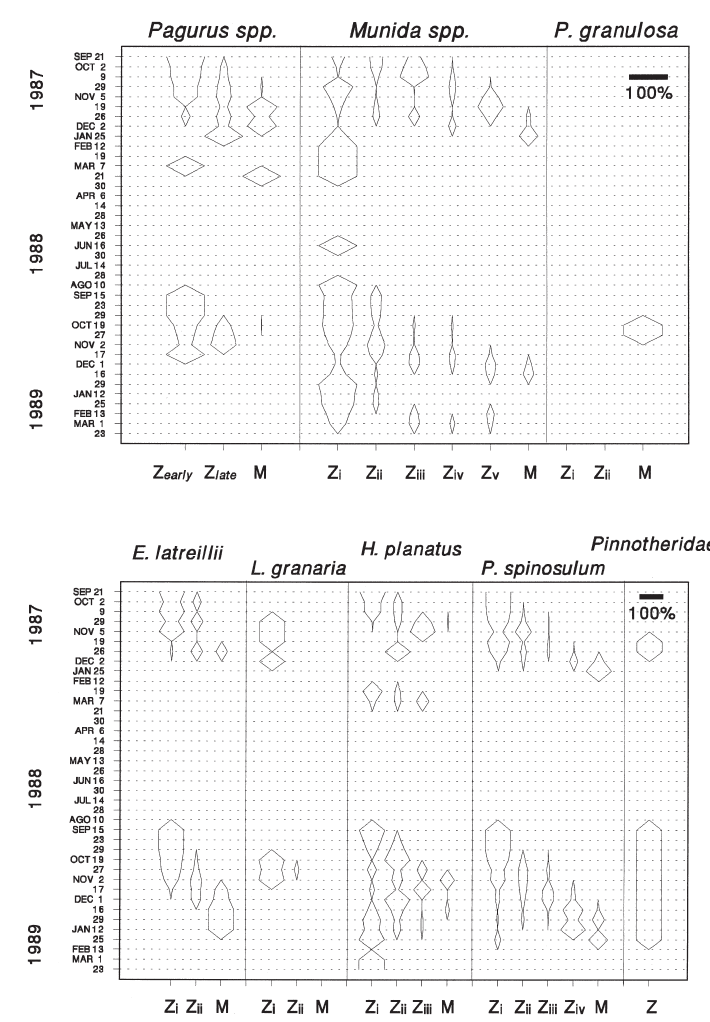
Rostrum bare; telson flat or slightly concave . 8 8. Posterior carapace spines small. Telson slightly flat; 6 to 8 pairs of spinulose processes . . . . . .